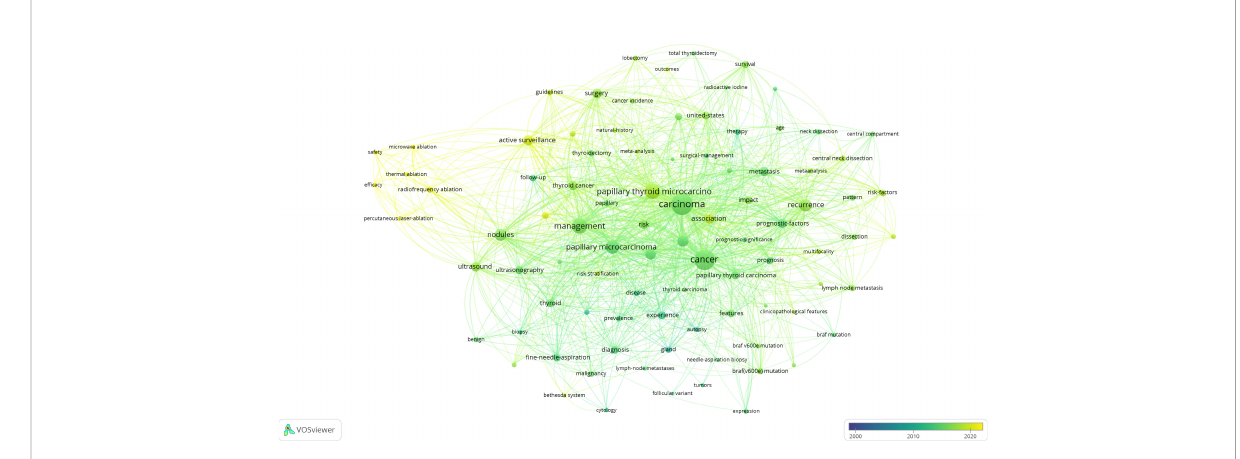
FIGURE 6 Overlay visualization of terms in PTMC publications from 2000 to 2021.